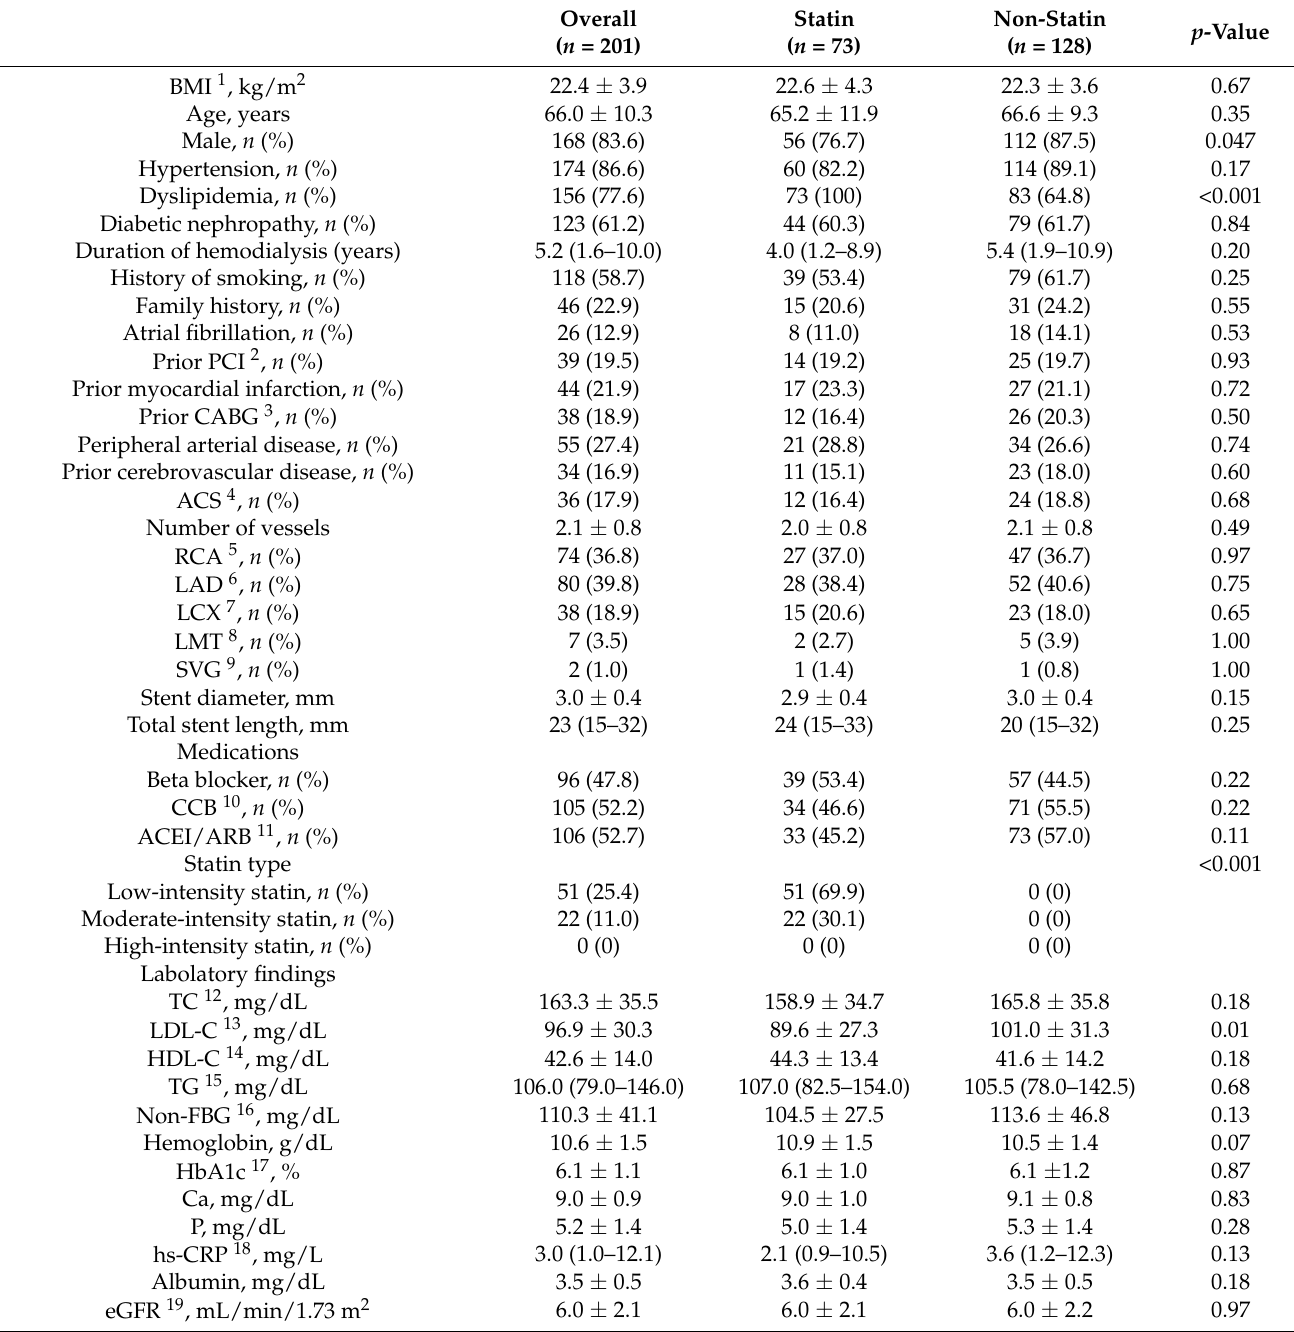
Table 1. Baseline clinical characteristics of the study